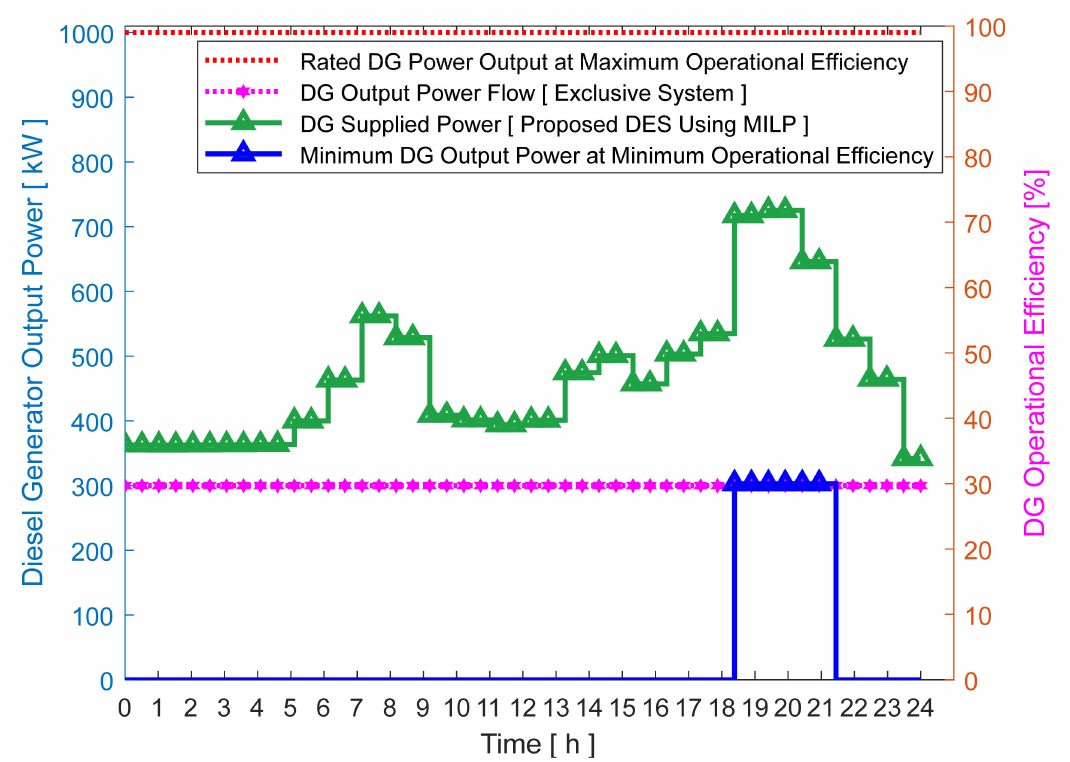
Figure 11. Analysis of power generation by DG power supply and operational